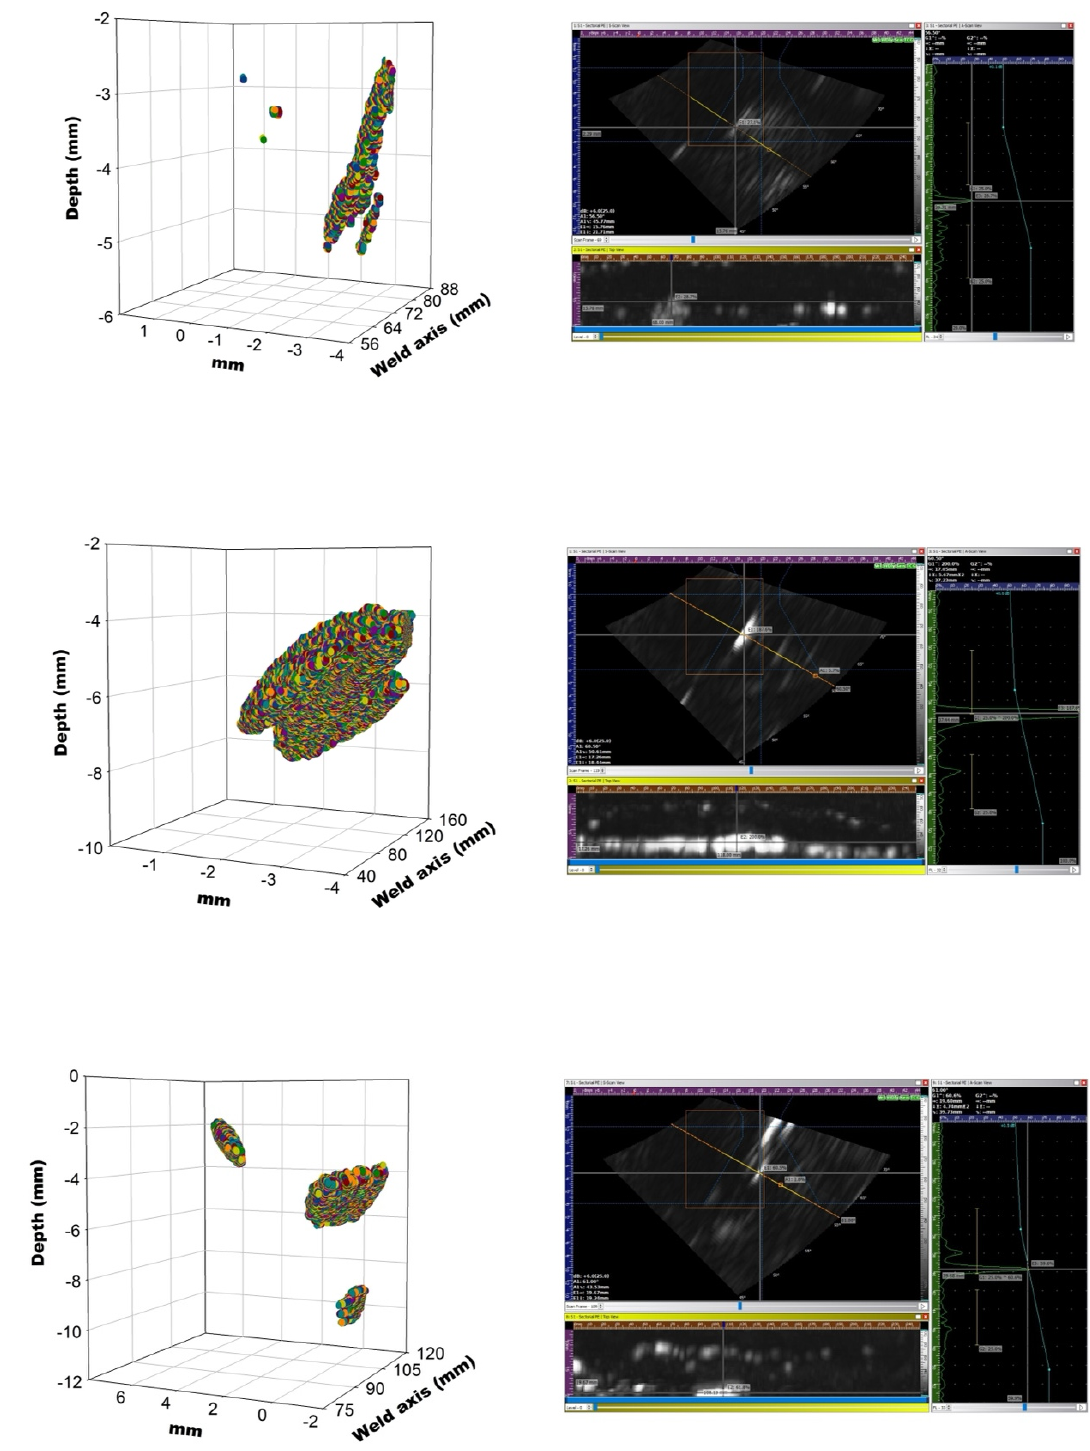
Figure 8. Three-dimensional reconstruction ( left ) and PA inspection ( right ) of case 1a ( top ), 1b ( middle ) and 3c ( bottom ) with reference to Figure 7.